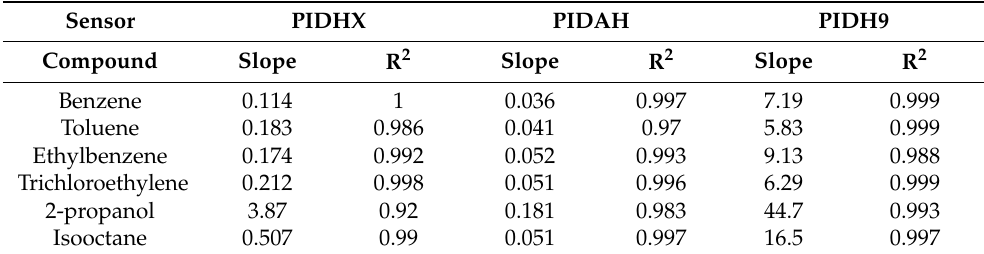
Figure 3. Benzene calibration functions. Table 5. Calibration parameters for the used